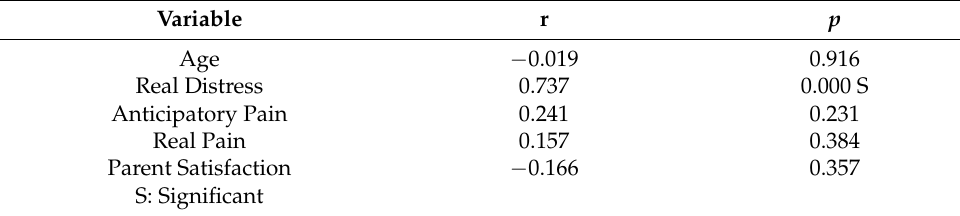
Table 1. Spearman’s correlation coefficient. Anticipatory